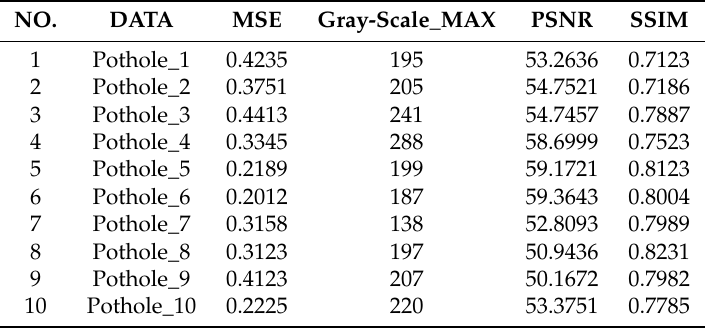
Table 2. The results of the evaluation of the distortion rate and the restoration rate.